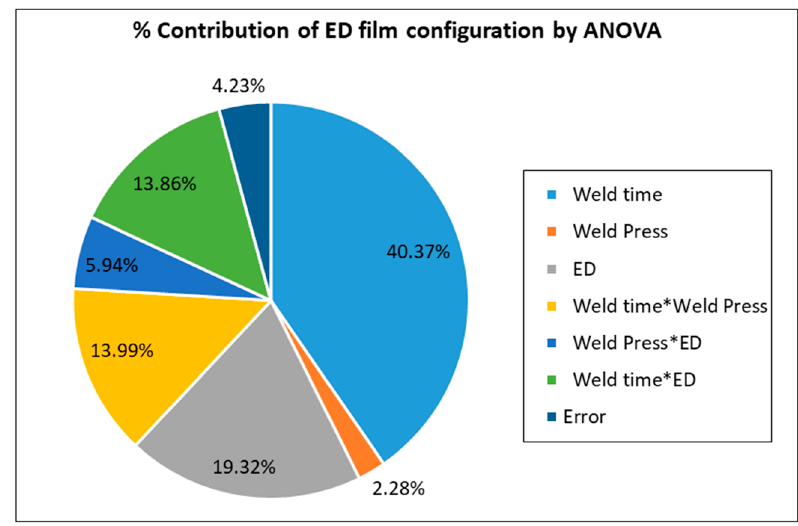
Figure A2. %Contribution of weld parameters for flat ED film by ANOVA. Figure A.2 %Contribution of weld parameters for flat ED film by ANOVA. Table A2. ANOVA analysis for ED film (FL-ELC_FL-ELC (0.5 and 0.25mm film)). Table A.2 ANOVA analysis for ED film (FL-ELC_FL-ELC (0.5 and 0.25mm film)). Analysis of Analysis of Variance